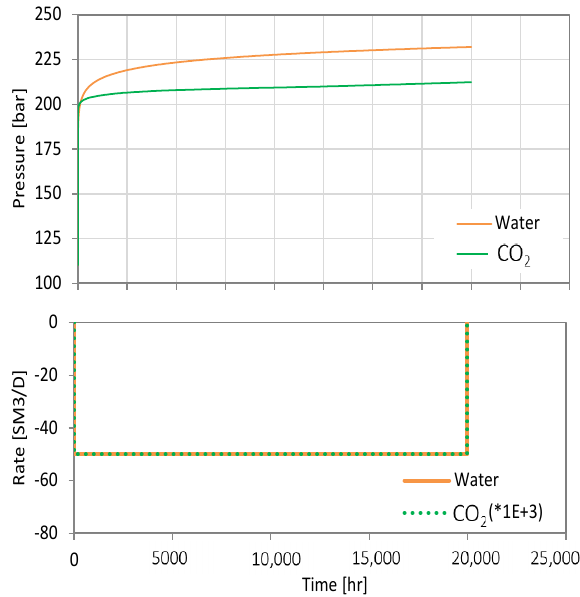
Figure 3. Pressure buildup as a response to continuous injection of water and CO 2 into infinite saline aquifer, 2D numerical simulations in Saphir. Injection rates are negative in contrast to positive production rates used by reservoir simulators.